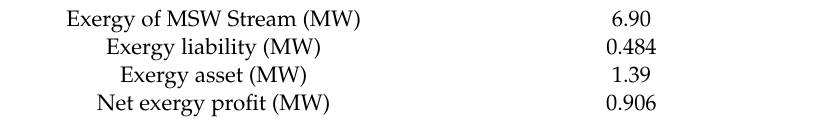
Table 7. Calculation results for MSW stream, on the basis of 1 t / h of MSW